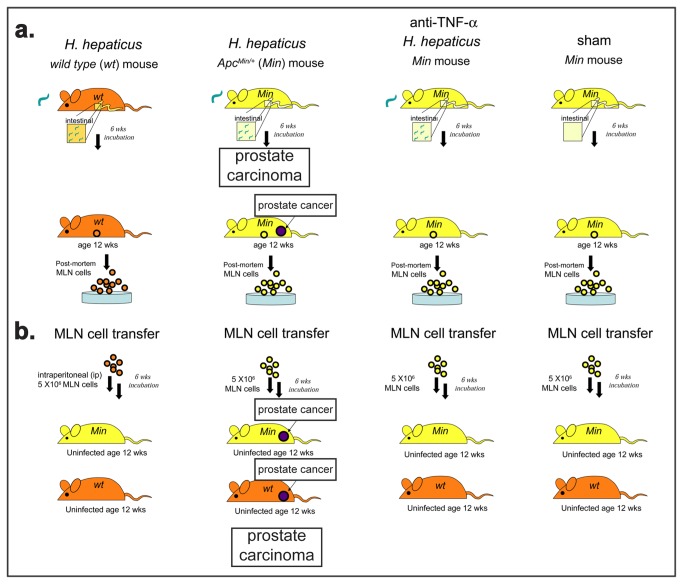
Transfer of mesenteric lymph node (MLN) cells from H hepaticus-infected mice is sufficient to recapitulate prostate cancer in uninfected mice.Schematic illustration of MLN cells transfer experiments designed to test the hypothesis that local GI tract immune network events cause systematic immune imbalances that determine the fate of preneoplastic lesions in topographically distant epithelia such as those of the prostate gland. Trials used 6 mice per group. Experiments were done in duplicate.